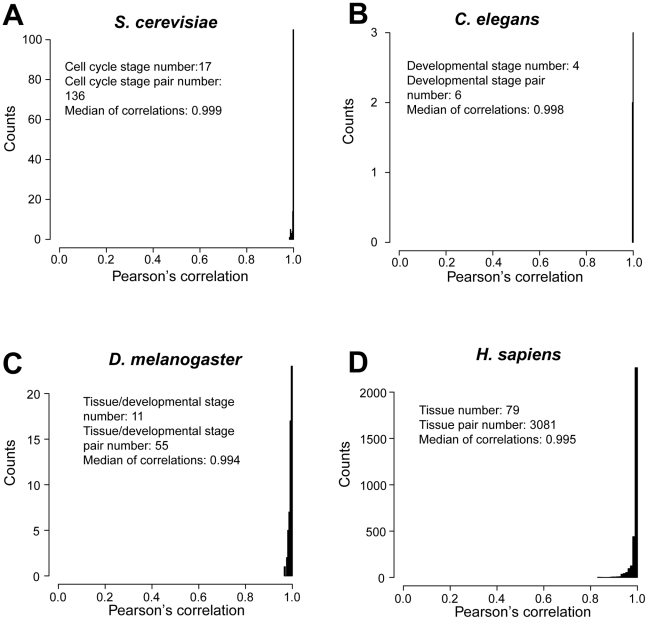
Similarity in transcriptomic codon usage across cell cycle stages, developmental stages, and tissues.Distributions of pairwise Pearson's correlations of codon usage among (A) mitotic cell cycle stages in S. cerevisiae, (B) developmental stages in C. elegans, (C) tissues and developmental stages in D. melanogaster, and (D) among tissues in H. sapiens.